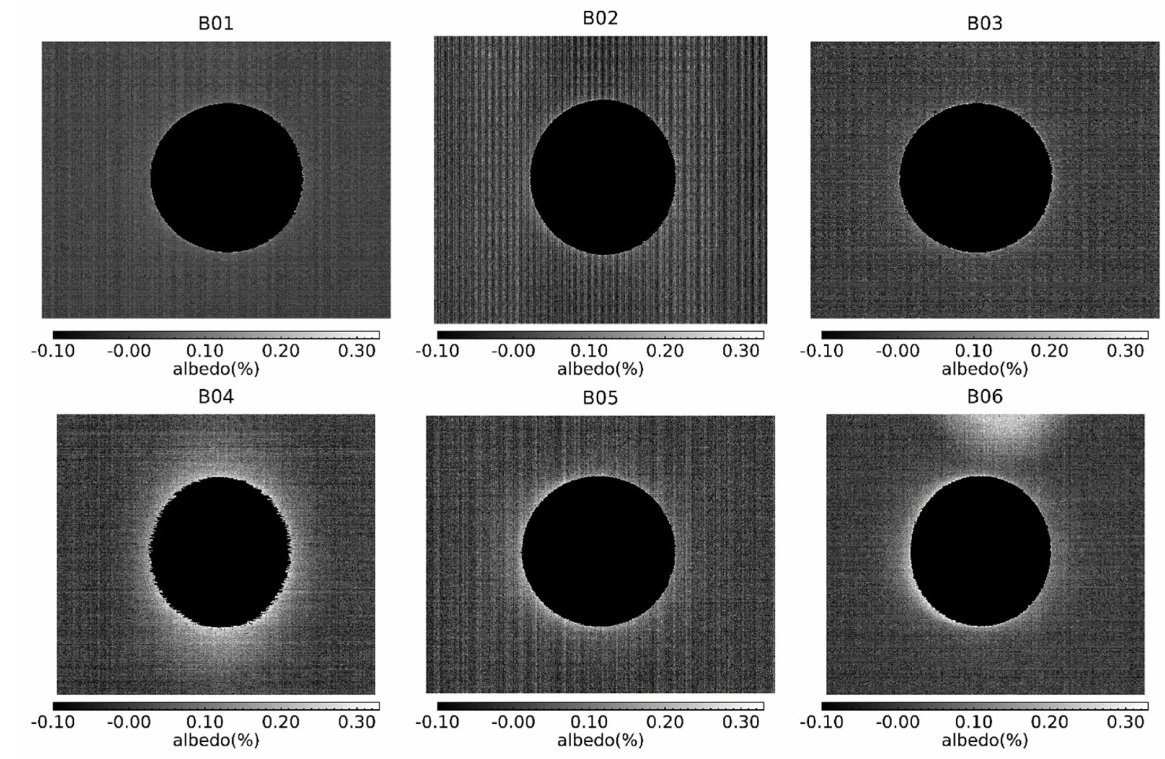
Figure 5. Same as Figure 4, with lunar samples (albedo larger than 0.33%) marked as −